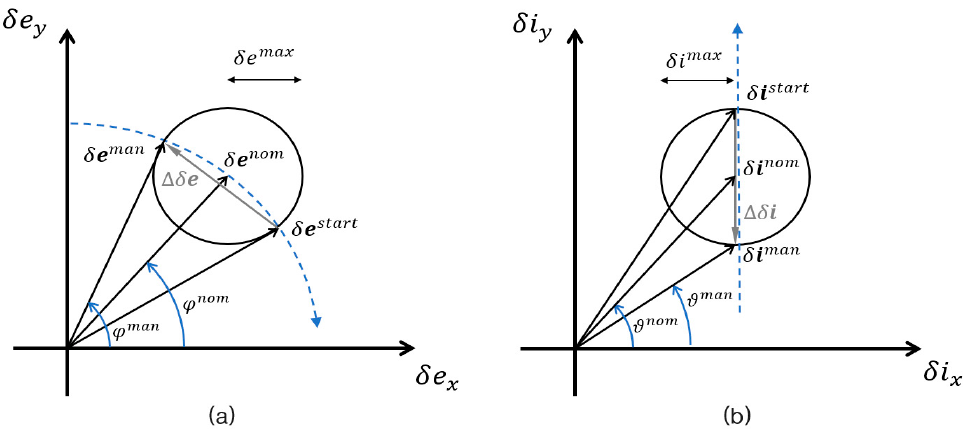
Figure 5. Relative orbit control concept for the relative eccentricity vector 𝜹𝒆 ( a ) and relative inclination vector 𝜹𝒊 ( b ) changed by the secular 𝐽 (cid:2870) effect.